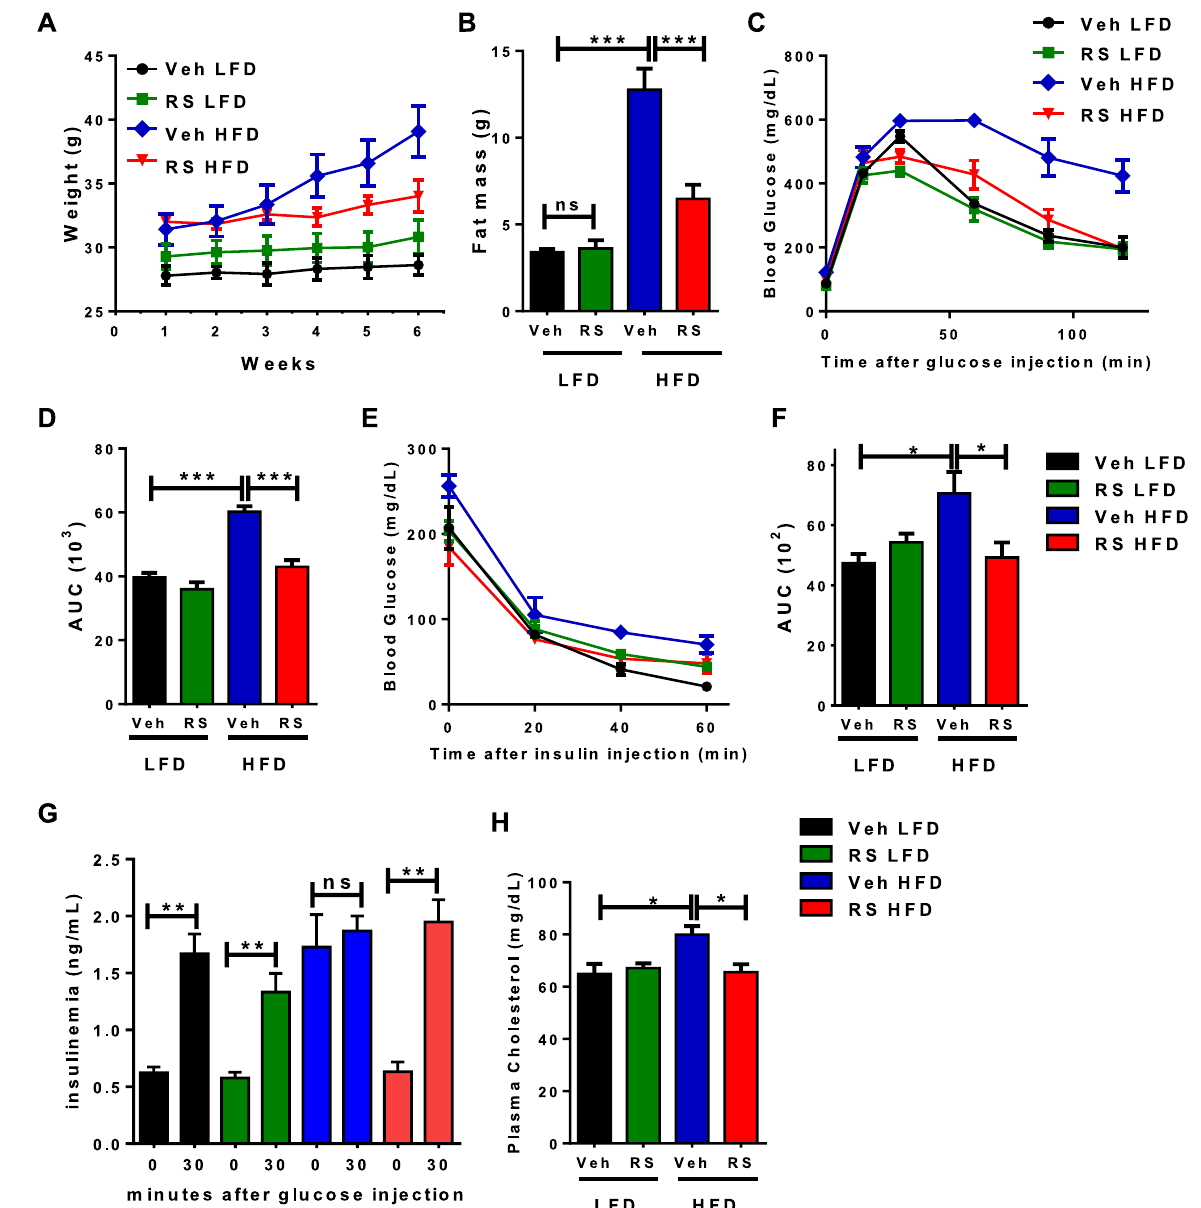
Figure 1. Roscovitine treatment reduces metabolic disruption in obese mice. ( A ) Body weight progression during the 6 weeks of roscovitine (50 mg/kg) or vehicle treatment starting 13 weeks of low-fat diet (LFD) or high-fat diet (HFD) feeding (n = 5 male mice/ group). ( B ) Fat mass determined by nuclear magnetic resonance (NMR). ( C ) Intraperitoneal glucose tolerance test (ipGTT) in 19–20 weeks LFD and HFD fed mice treated for 6 weeks with roscovitine or vehicle and ( D ) the corresponding area under the curve (AUC) of ipGTT (n = 5 male mice / group). ( E ) Intraperitoneal insulin tolerance test in 19–20 weeks LFD and HFD fed male mice treated for 6 weeks with roscovitine or vehicle and ( F ) the corresponding area under the curve (AUC) of ipGTT (n = 5 male mice/group). ( G ) Blood insulin levels as measured during ipGTT in LFD and HFD fed male mice treated for 6 weeks with roscovitine or vehicle (n = 5). ( H ) Fasting plasma cholesterol level in 19–20 weeks LFD and HFD fed male mice treated for 6 weeks with roscovitine or vehicle (n = 5/group). Data were analyzed and illustrated using GraphPad Prism 6.0 software (GraphPad, https:// www. graph pad. com). All values are expressed as means ± SEM; *p < 0.05, **p < 0.01, and ***p <